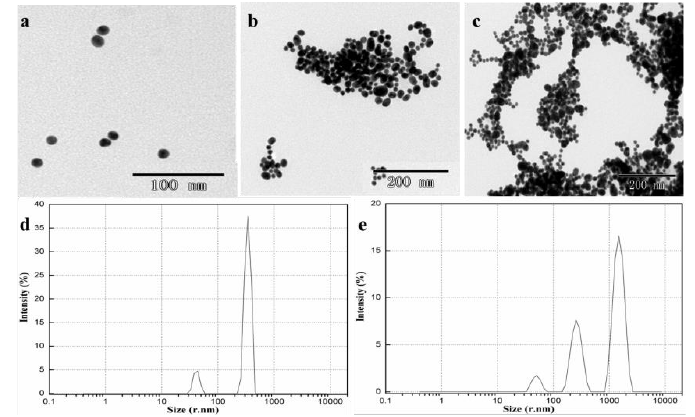
Figure 2. Transmission electron microscope (TEM) images of ( a ) AuNPs with 2.0 mg/L metsulfuron-methyl; ( b ) AuNPs with 2.0 mg/L metsulfuron-methyl and 2.0 mg/L melamine; ( c ) AuNPs with 2.0 mg/L melamine, the particle size distributions images of ( d ) AuNPs with 2.0 mg/L metsulfuron-methyl and 2.0 mg/L melamine; and ( e ) AuNPs with 2.0 mg/L melamine (acetate buffer solution: 10 mM, pH 3.5, 0.2 mL).